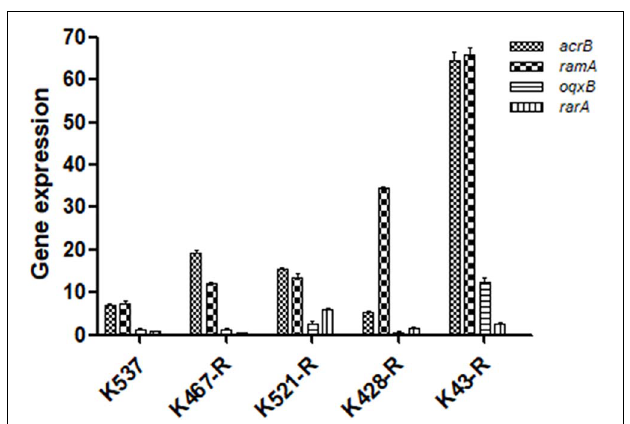
FIGURE 2 | Expression of pump and regulator encoding genes including acrB , ramA , oqxB , and rarA in five tigecycline-resistant CRKP strains. The values were expressed as mean ± standard deviation